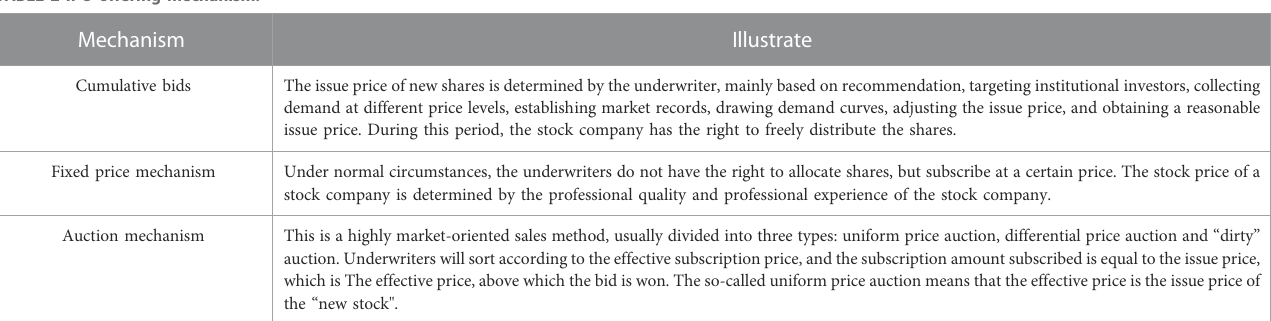
TABLE 2 IPO offering mechanism.